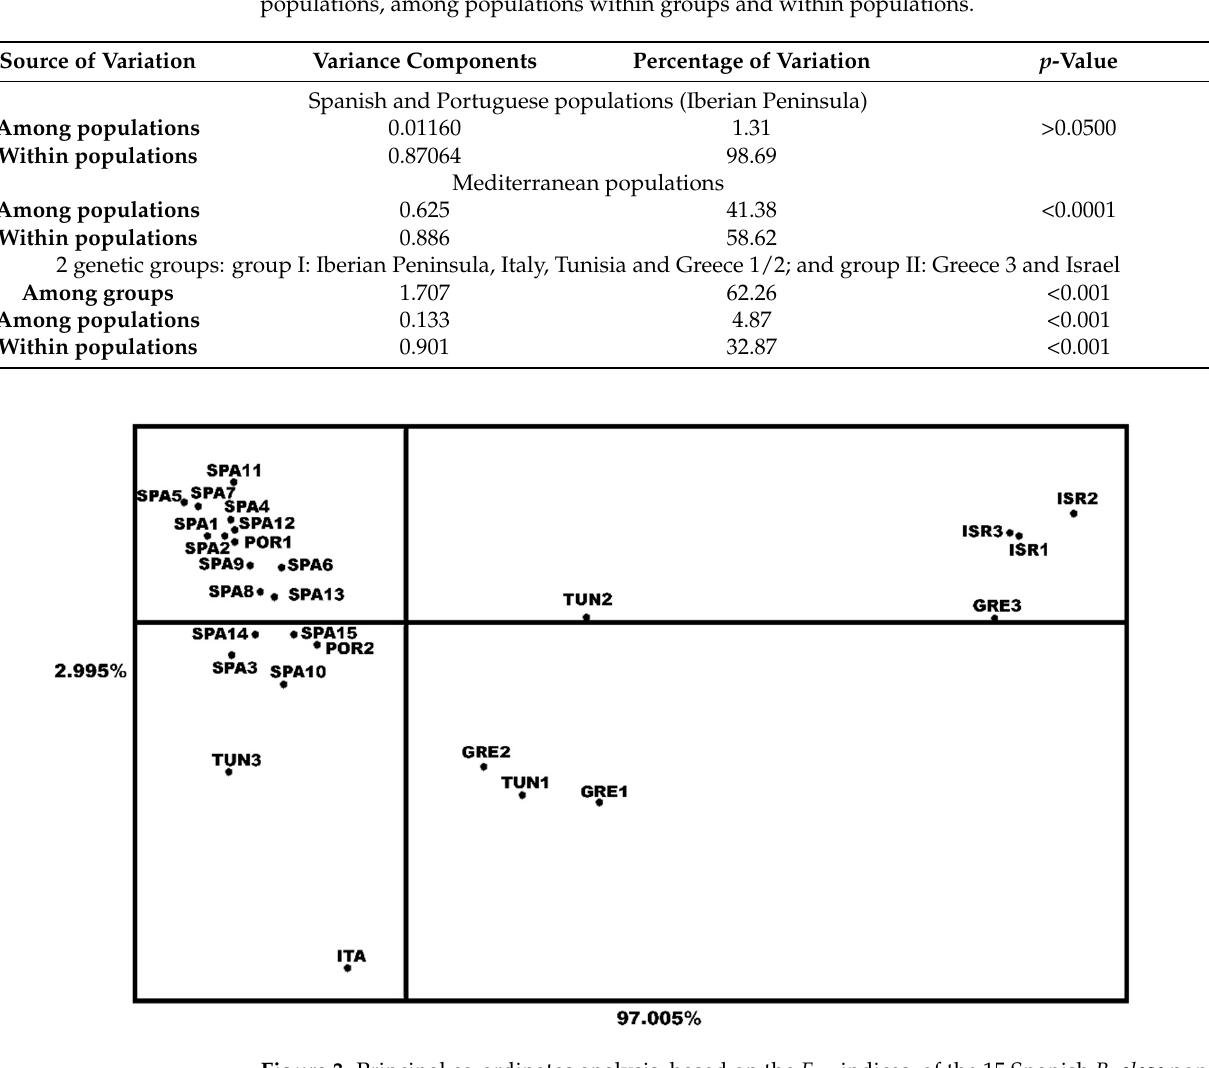
Figure 3. Principal co-ordinates analysis, based on the F ST indices, of the 15 Spanish B. oleae popula- tions analysed plus 12 from other olive oil producer countries. The Eigenvalues for each principal component are listed besides each